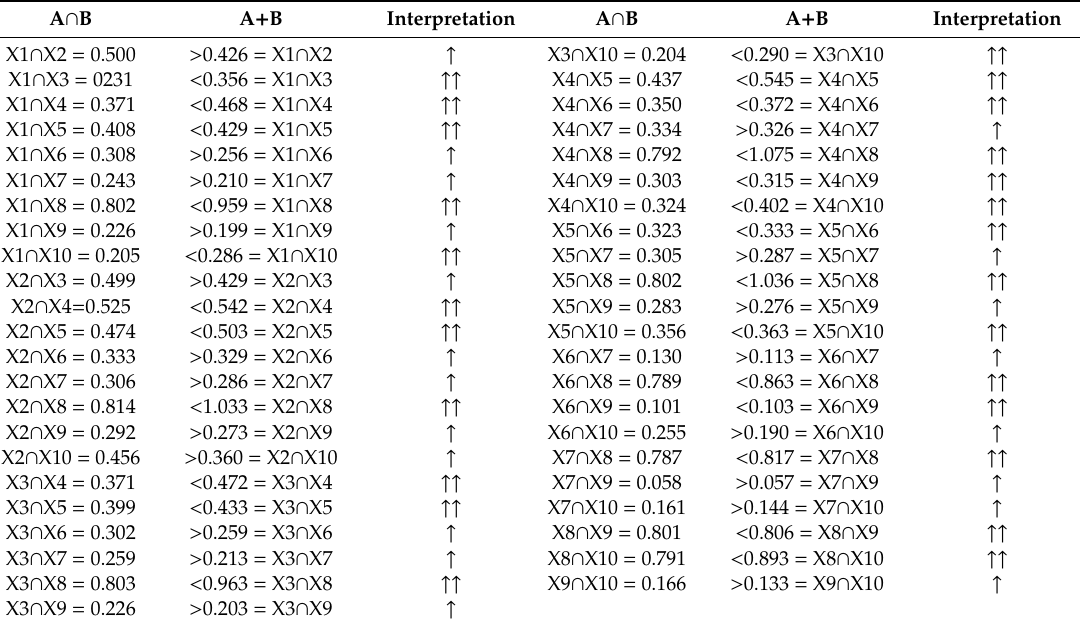
Table 8. Interaction detection between ecosystem health influence